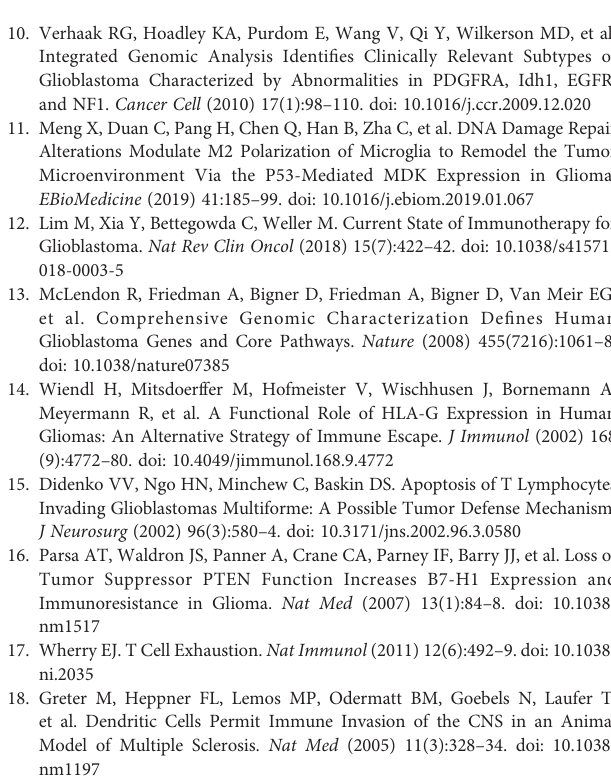
Supplementary Figure 1 | GO bubble plots of metagenes in Immune-H over immune-L phenotypes. (A – C) Bubble plots for TCGA microarray, TCGA GBM RNA-seq, CGGA RNA-seq